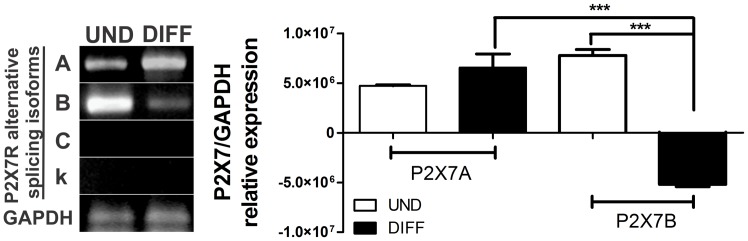
Differential expression of P2X7R alternative splicing isoforms in undifferentiated and neural- differentiated ESC.(A) P2X7 receptor isoform A, B, C and k expression in undifferentiated (UND) and cells following 8 days of neural differentiation (DIFF) was determined by RT-PCR. (B) P2X7R isoforms expression levels were obtained and analyzed by densimetric analysis of DNA bands and were compared to GAPDH expression levels. Data were analyzed for statistical relevance with the One-Way ANOVA test followed by the Bonferroni post hoc test (*p<0,05,**p<0,01, ***p<0.001 compared to control data).